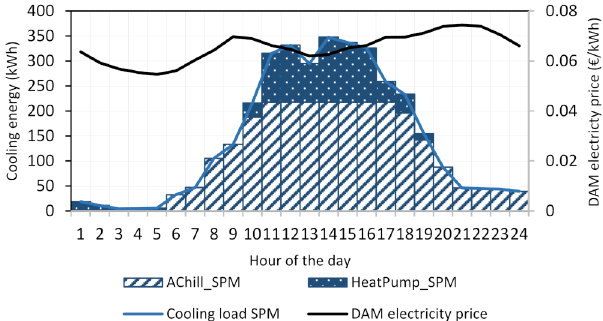
Figure 26. Cooling energy balance of the SPM obtained with stochastic economic optimization for the representative summer day.